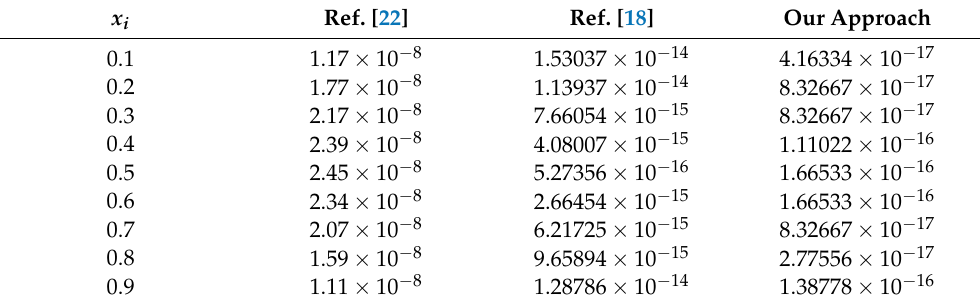
Table 1. Absolute errors for Example 1.